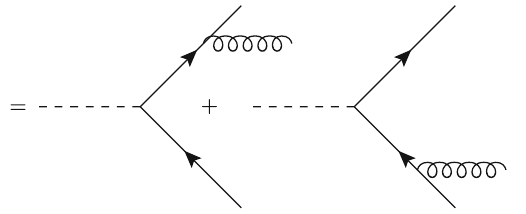
Fig. 3 The two diagrams contributing to the H → b ¯ bg amplitude. In dred and fdh there are additional diagrams with gluons replaced by (cid:3) -scalars